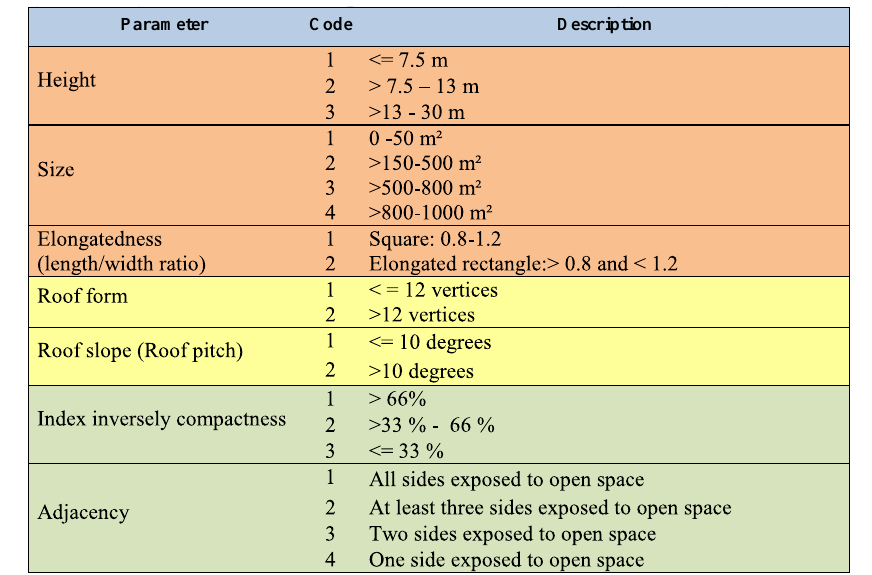
Table 1. Range of categories for the seven parameters of the building